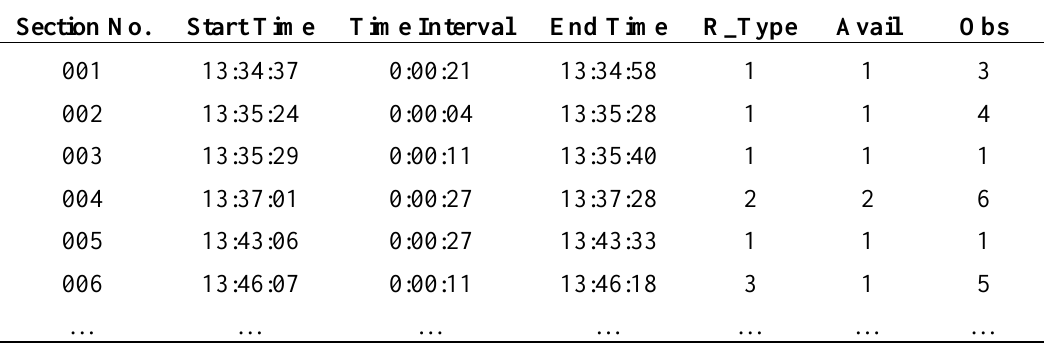
Figure 9. Results of field survey to collect GPS trajectories. Table 5. Example of collected GPS points data.